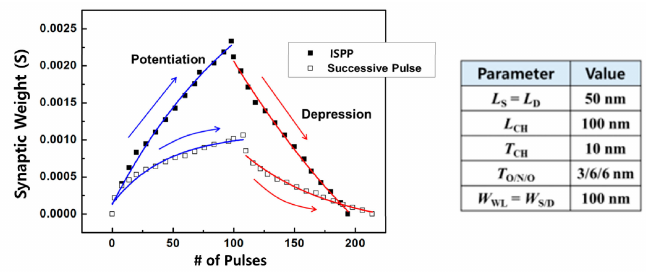
Figure 6. Gradual changes of synaptic weights by successive-pulse programming and incremental-step-pulse programming